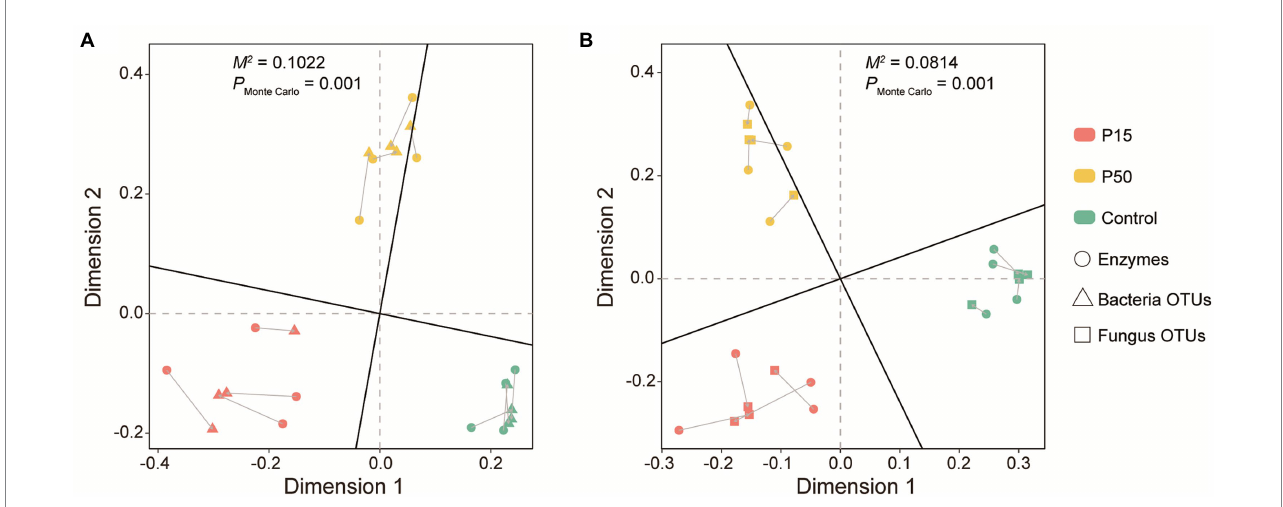
FIGURE 4 Procrustes analysis between soil bacterial (A) , fungal (B) community composition and enzyme profiling in the Cinnamomum camphora coppice planting. P15, point under the tree canopy; P50, point between trees; Control, point in the abandoned land. The lengths of connecting lines represent the dissimilarities of soil bacterial, fungal community composition and enzyme profiling.